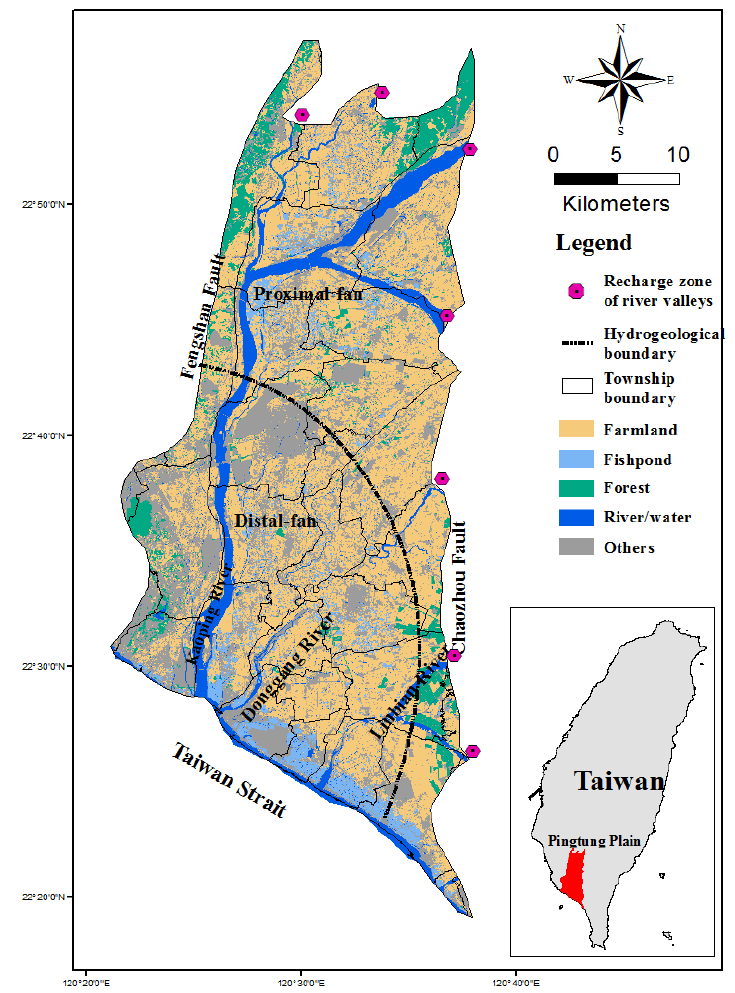
Figure 1. Land use in the study area.